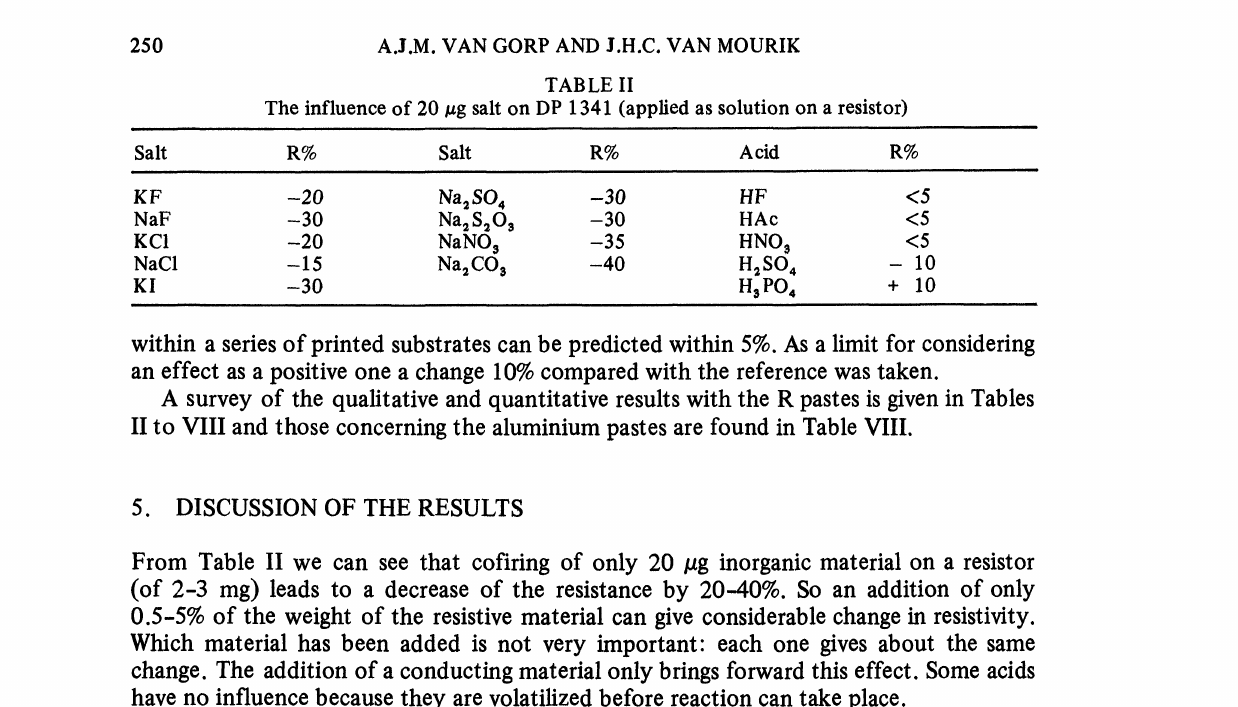
TABLE III The influence of 5 mg salt applied on a separate